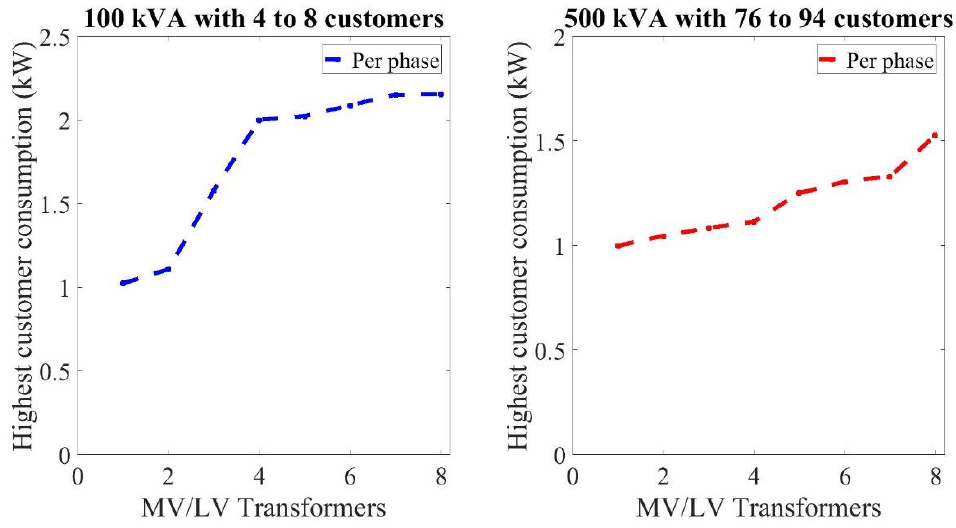
Figure 2. The highest consumption per customer per phase for 100 kVA and 500 kVA rated transformers.